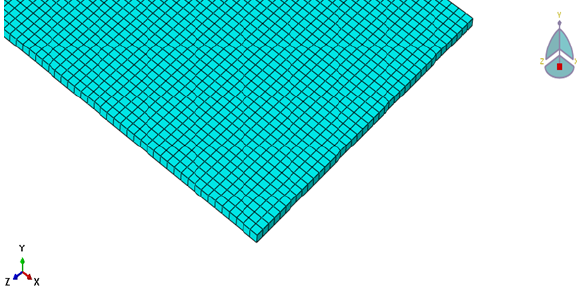
Fig. 7. Adhesive layer with appropriate mesh element size.